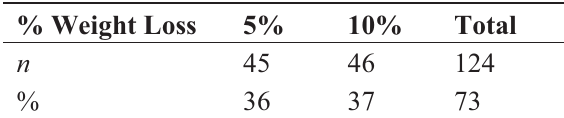
Table 4. Percentage of total body weight